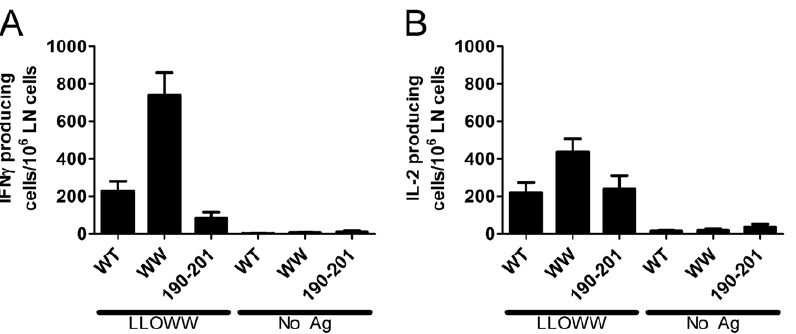
Figure 7. ELISpot response following immunization with LLO or LLO peptide. A–B. C57BL/6 mice were immunized in the footpad with 250 picomoles of either LLOWT, LLOWW, or LLO(190–201) peptide emulsified in incomplete Freund’s adjuvant. After 7 days, draining lymph nodes were isolated and the number of IFN c ( A ) and IL-2 ( B ) producing cells was determined by ELISpot. Recall antigen was either LLOWW at 10 nM or no antigen. Bars represent the mean + / 2 SEM for 2–6 mice per group over three independent experiments. Analysis of the data using D’Agostino & Pearson omnibus normality test followed by student t test revealed that the increase in IFN c production following immunization with LLOWW was significant when compared to both LLOWT or LLO(190–201) immunization (p=0.0012 for LLOWT vs. LLOWW and p , 0.0001 for LLOWW vs. LLO(190– 201).